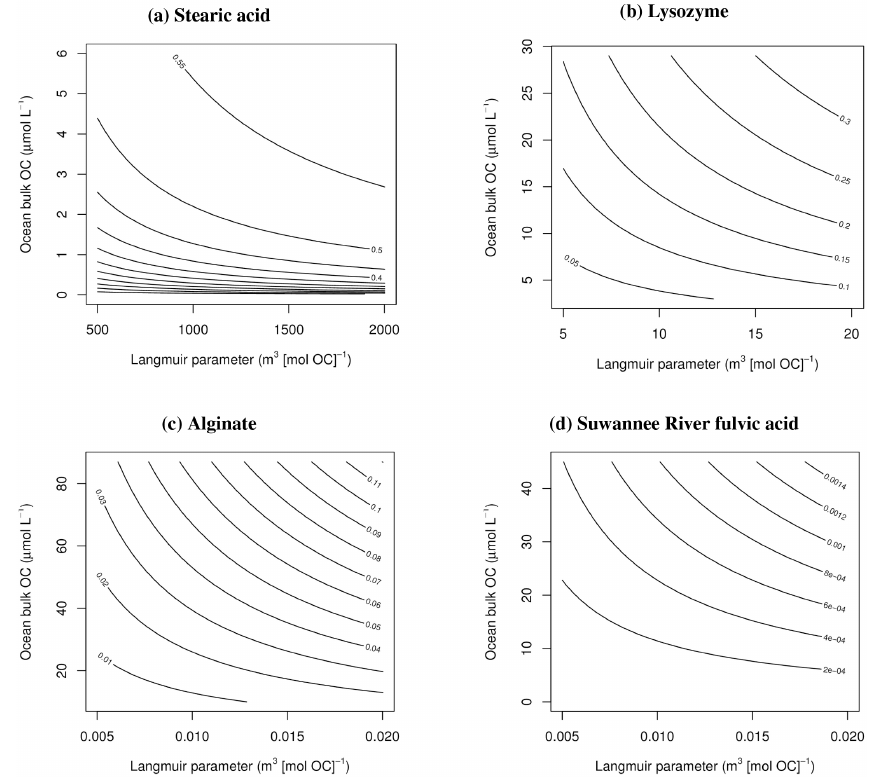
Figure 4. Organic mass fraction in dry aerosol (OM:(NaCl+OM) mass ratio), predicted organic mass fractions for model compounds as a function of Langmuir parameter α i (m 3 (mol OC) − 1 ) and OC molar concentration. Ranges of OC concentration (vertical axis) are estimated for classes of molecules from ocean biogeochemical model output, as described in Sect. 5, and chemical parameters are as indicated in Table 2. Ranges of Langmuir parameters (horizontal axis) are obtained by varying α i between 0.5 and 2 times the respective model compound value from the BASE case.